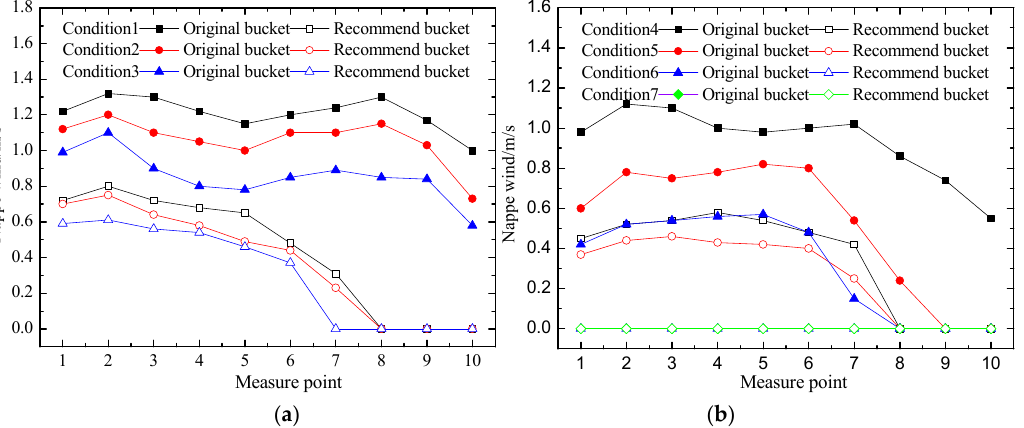
Figure.14 Nappe wind at the upstream slope of the powerhouse of the physical model test; (a) represents the nappe wind of condition 1 to condition 3; (b) represents the nappe wind of condition 4 to condition 7.